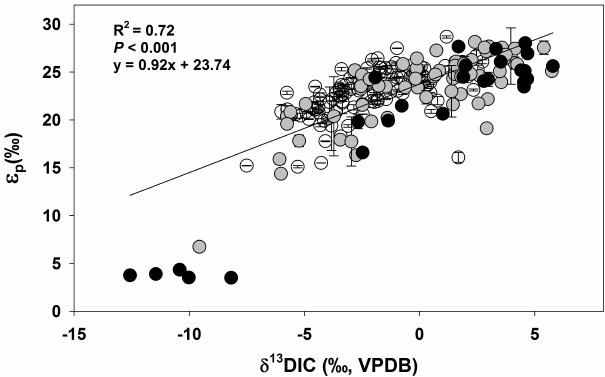
Figure 5. Linear relationship between the stable isotopic signature of the ambient DIC pool and photosynthetic carbon fractionation ( ε p ; biomass relative to ambient CO 2 ). The color of the points indi- cates Chl a concentration: white = 0–40µg Chl a L − 1 ; grey = 41– 100µg Chl a L − 1 ; black = >100µg Chl a L − 1